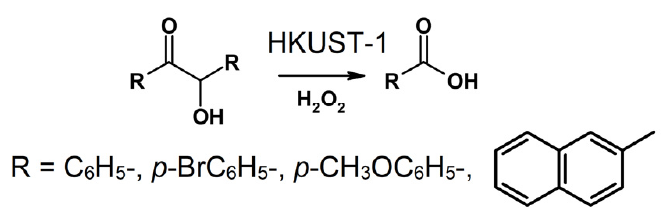
Figure 4. Catalytic oxidation of benzoin and substituted benzoins with excess of H 2 O 2 in the pres- ence of HKUST-1.